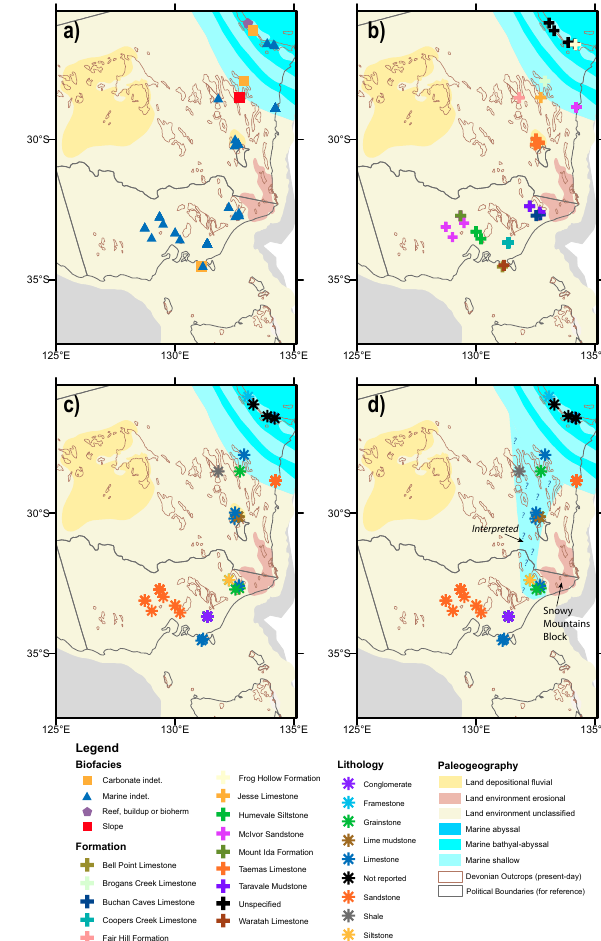
Fig. 6. (a) Paleogeographic reconstruction at 402Ma (Early Devo- nian/Emsian) from Geoscience Australia Palaeogeographic Atlas of Australia with inferred paleoenvironments from fossils, present-day Devonian outcrops and reconstructed political boundaries for ref- erence. Fossil specimens (including echinoderms, shell and skele- tal fragments) in New South Wales and Victoria indicate shallow marine environments. The fossils have well-constrained temporal descriptors indicative of Early Devonian times, with a number of specimens better tied to Emsian times based on conodont zones (i.e. Eognathodus trilinearis , Polygnathus dehicens , etc.). (b) Pa- leogeographic reconstruction with formation types indicated, based on fossil metadata. (c) Paleogeographic reconstruction with fossil lithologies indicated, based on metadata. (d) A reinterpretation of Emsian paleogeography, suggesting marine environments persisted until at least Emsian times in Victoria, and linking the marine in- undation to the Yass Shelf to be more consistent with the interpre- tations of Webby (1972) and the overall N–S striking convergent margin of Australia at this